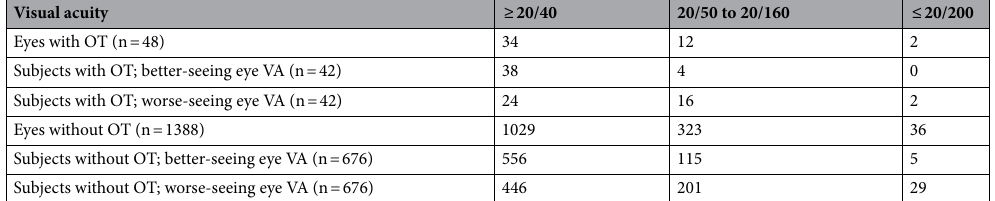
Table 4. Presenting visual acuity between subjects and eyes with and without ocular toxoplasmosis (n = 718 subjects and 1436 eyes). Three subjects (six eyes), all without presumed toxoplasmosis lesions, were unable to report VA. OT: ocular toxoplasmosis; VA: visual acuity.